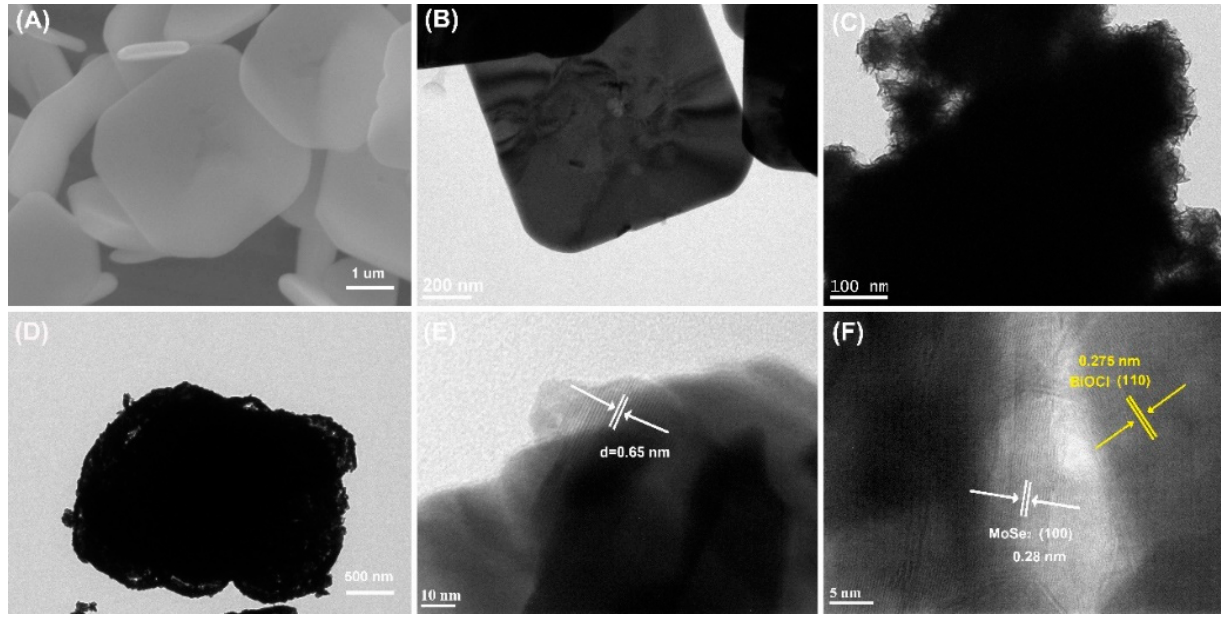
Figure 1. ( A ) SEM image of BiOCl. ( B – D ) TEM images of ( B ) BiOCl, ( C ) MoSe 2 , and ( D ) BiOCl/MoSe 2 -30. ( E , F ) HR-TEM images of BiOCl/MoSe 2 -30.